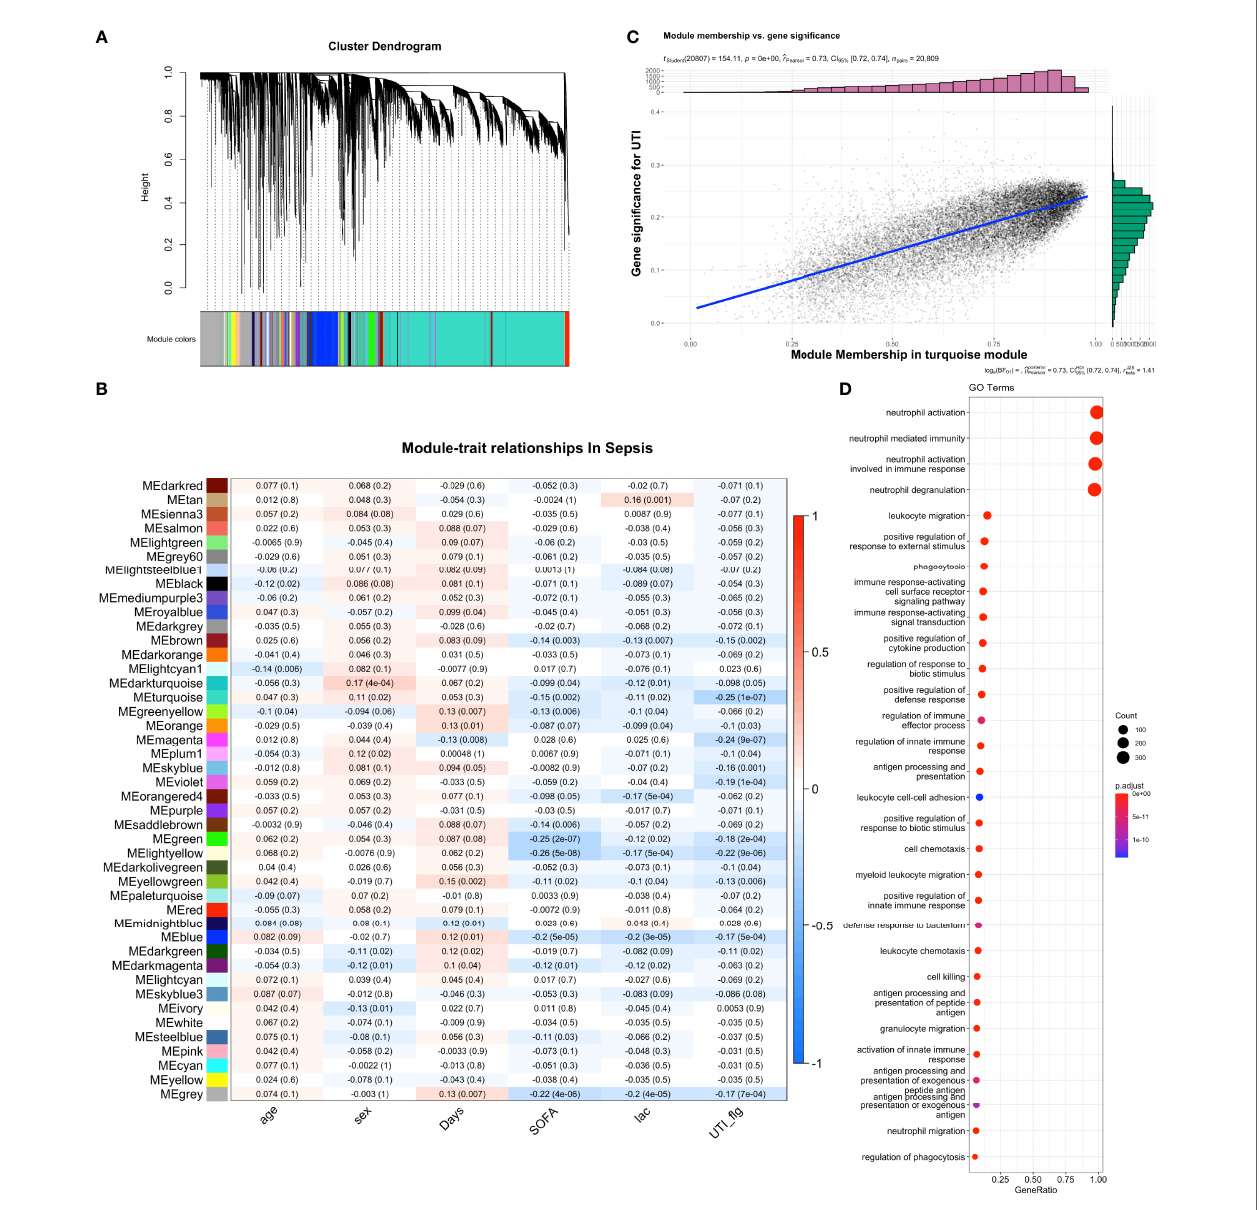
FIGURE 3 | Weighted gene co-expression network analysis (WGCNA) of bulk RNA-seq samples. (A) Dendrogram clustering of the co-expressed genes into modules. Modules were labeled by different colors. (B) module-trait relationship in sepsis samples. The blue color indicates negative correlation and the red color indicates the positive correlation. The numbers in each cell are Pearson ’ s correlation coef fi cients between module eigengene and trait values, with p values shown in the parenthesis. (C) Correlation between module membership and gene signi fi cance for UTI. Each dot represents a gene. Gene signi fi cance was quanti fi ed by comparing gene expression between UTI and control groups. Module membership of a given gene was quanti fi ed by correlating its expression pro fi le with the module eigengene. (D) Gene set enrichment analysis of the turquoise module with GO